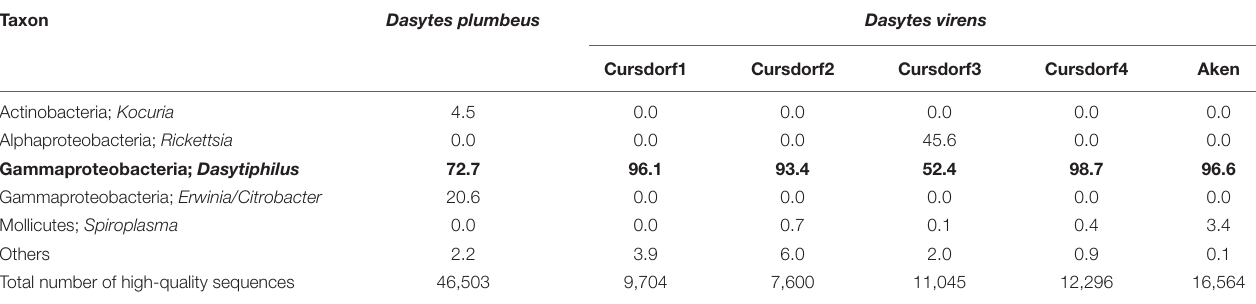
TABLE 2 | Bacterial community associated with Dasytes plumbeus ( n = 1) and D. virens ( n = 5) as revealed by bacterial tag-encoded FLX sequencing of 16S rRNA amplicons. Taxon